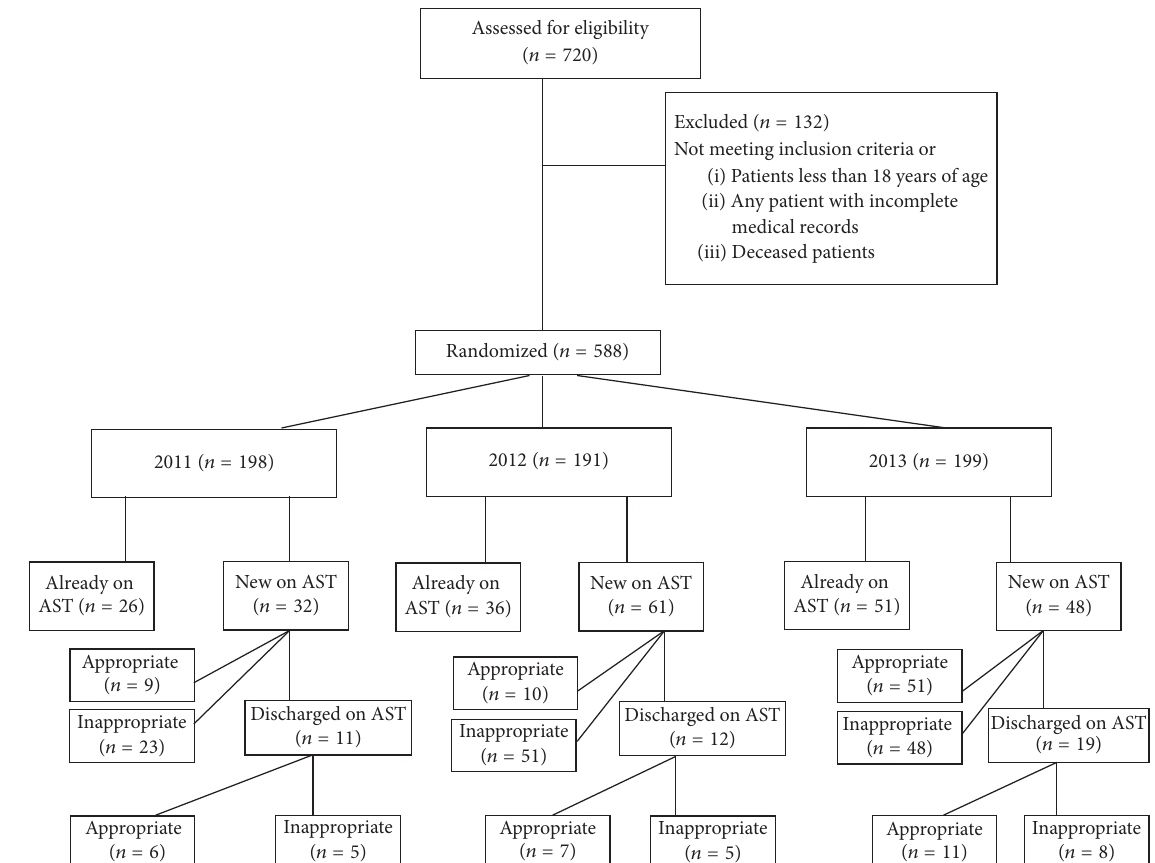
Figure 1: AST use during hospitalization from 2011 to 2013. AST: acid suppressive